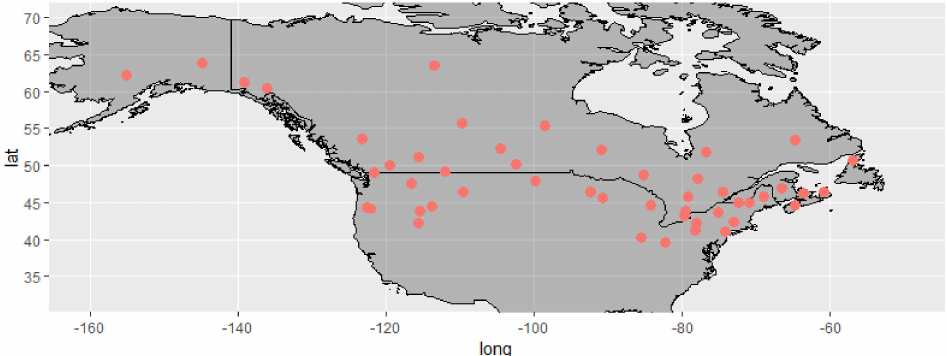
Figure 1. Gauging stations locations for catchments that were selected in North America.